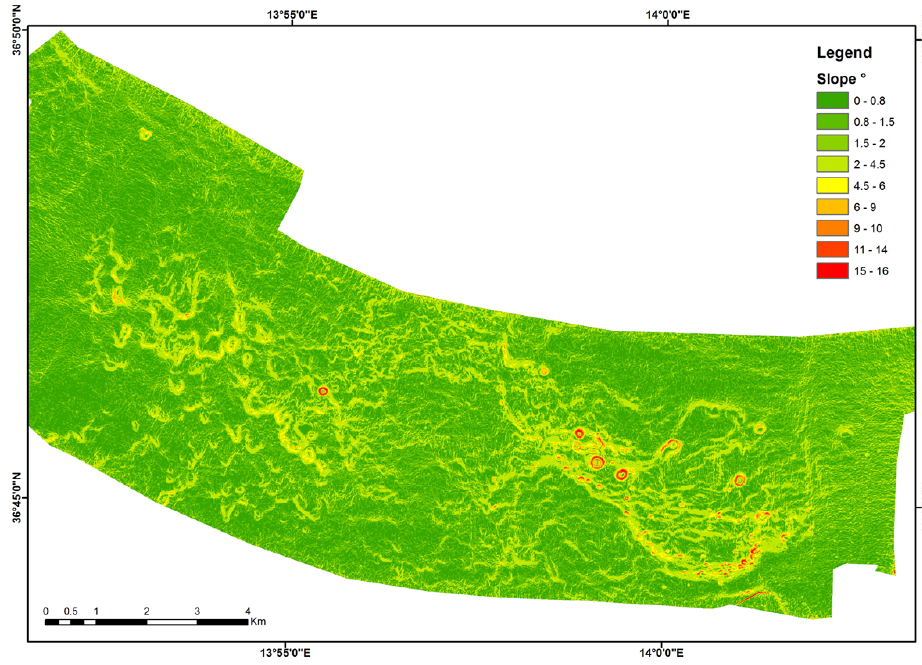
Fig. 4. Slope map of the study areas, calculated from the DTM, showing clearly the difference between the side slope of the pockmarks reaching the maximum of 16 ◦ and the regional surrounding slope about 2–3 ◦ .